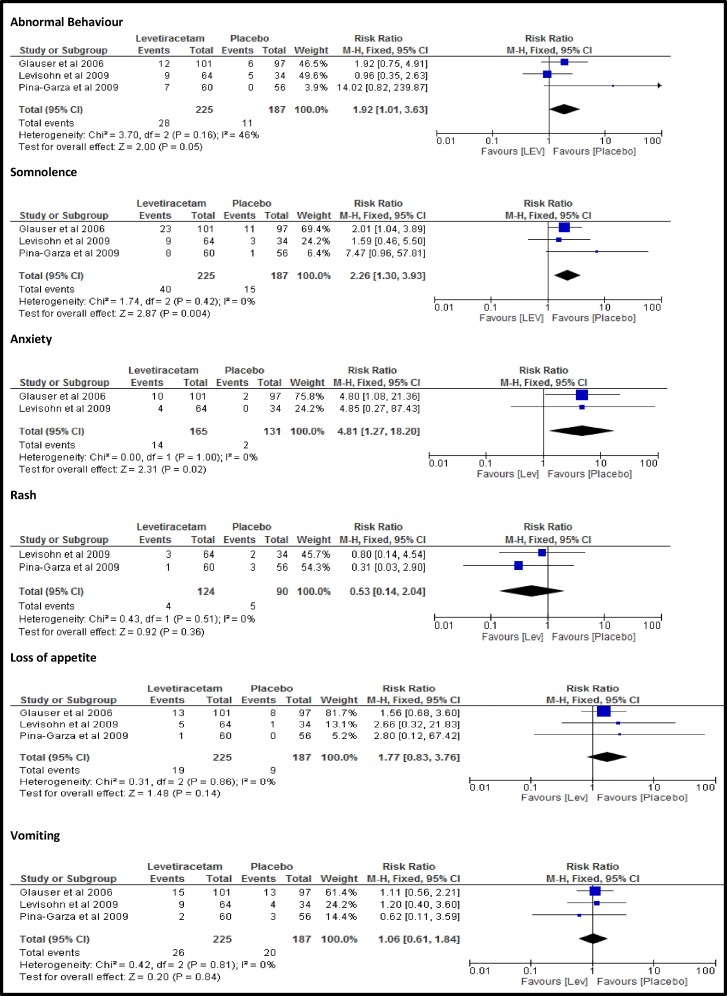
Relative risks of AEs of LEV and placebo.